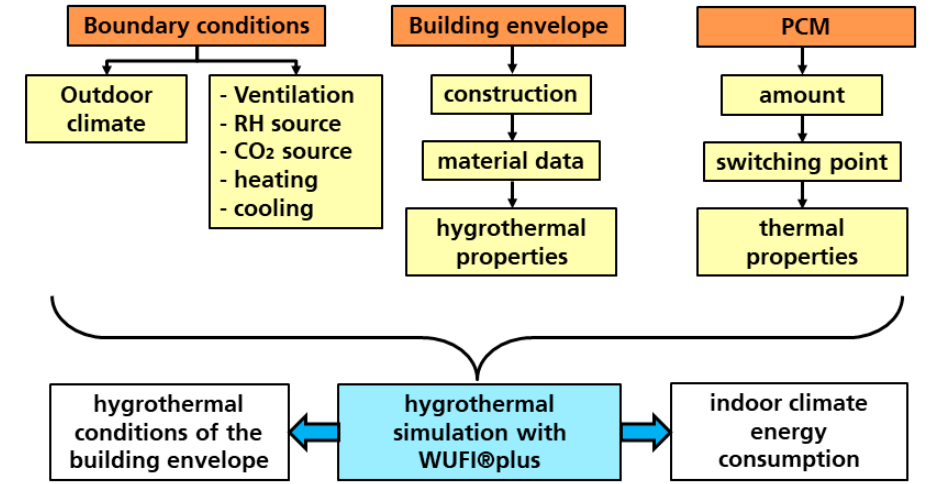
Figure 5. Flowchart for carrying out a hygrothermal building simulation using PCMs.